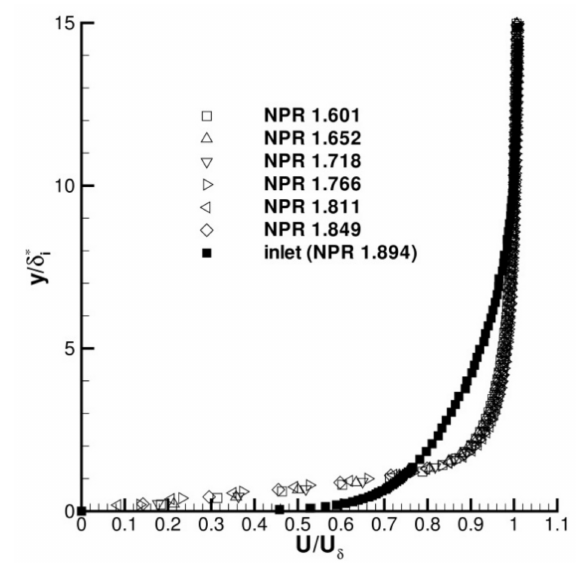
Figure 9. LU60 nozzle inlet and exit velocity profiles (probe